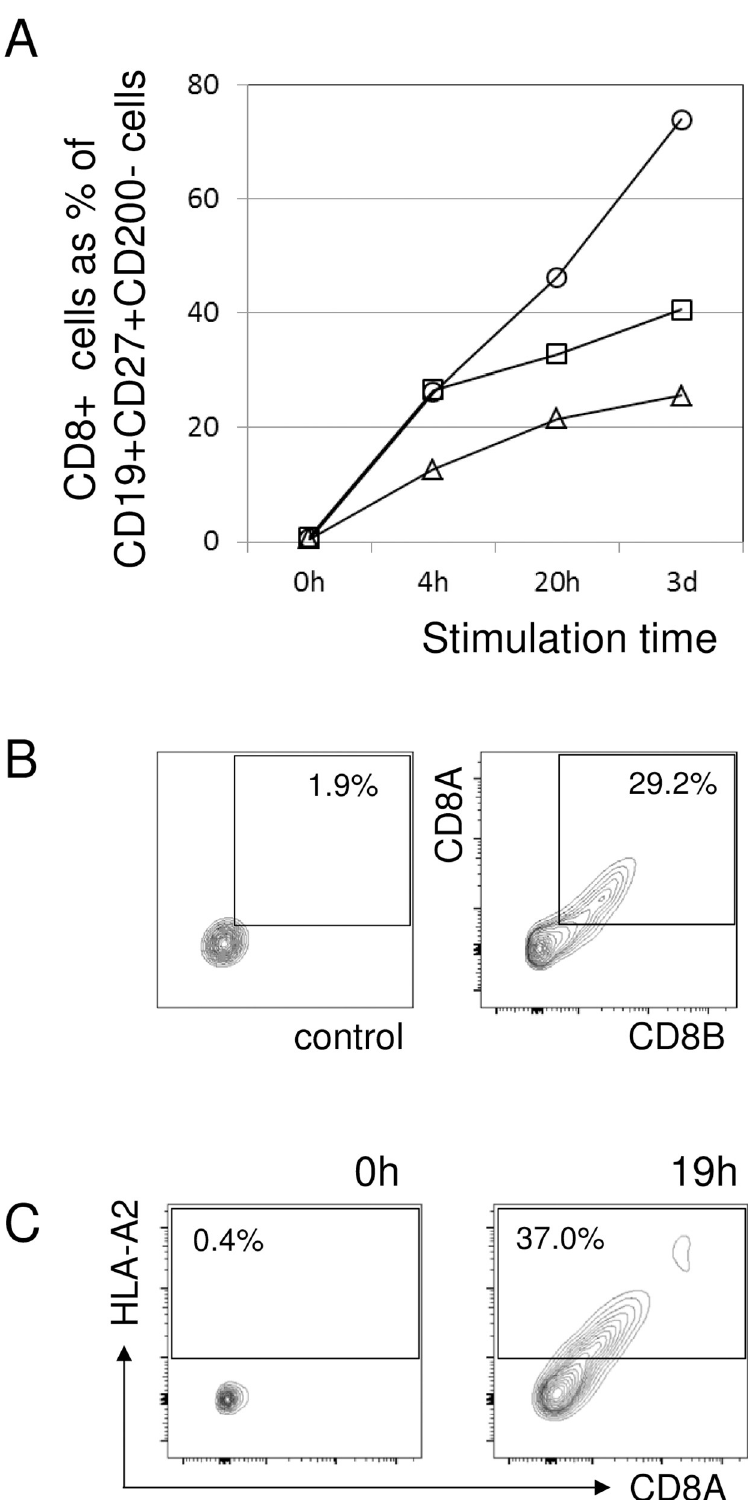
Fig 7. Transfer of molecules to B cells. (A) Percentage of CD8 positive cells within the CD19+CD27+CD200- B lymphocytes is increasing with cultivation time. Each series represents an independent blood (PBMC) donor. (B) Coexpression of CD8A and CD8B on CD19+CD27+CD200- B lymphocytes from a representative apheresis donor